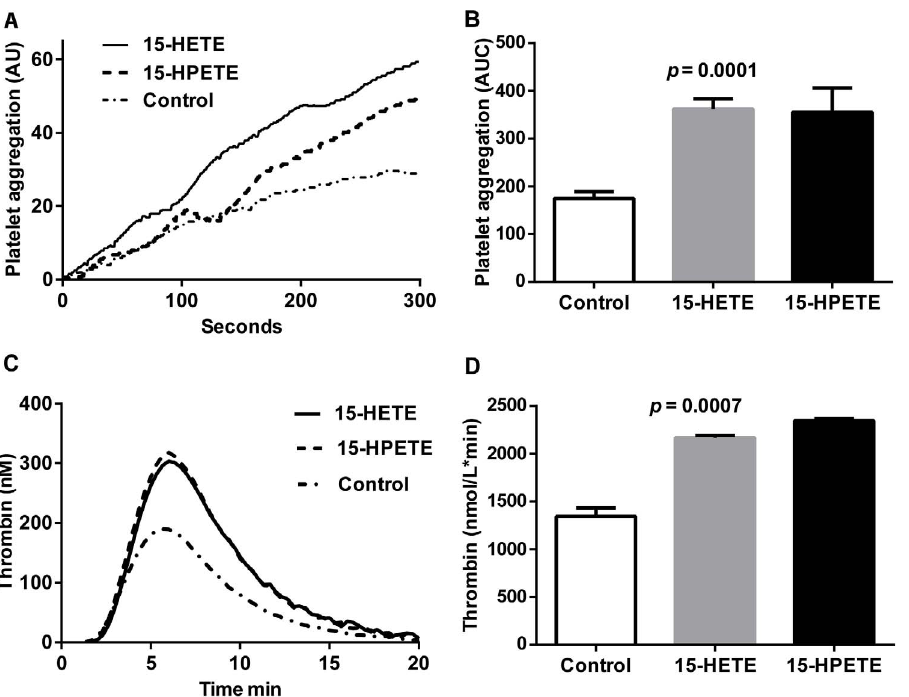
Figure 2. Platelet aggregation and thrombin formation are increased by ALOX15B enzyme products. (A, B) Platelet aggregation was measured in blood (from healthy volunteers) in the presence or absence of 10 nmol/L 15-HETE or 15-HPETE or ethanol control. ( A ) A representative experiment showing platelet aggregation over time. ( B ) Area under the curve (AUC) of platelet aggregation. Data are mean 6 SEM from 4 independent experiments (i.e. 4 blood donors) analyzed in duplicate. ( C, D ) Thrombin generation was measured in pooled normal plasma in the presence or absence of 10 nmol/L 15-HETE or 15-HPETE or 2% DMSO control. ( C ) A representative experiment showing thrombin generation curves. ( D ) The total amount of thrombin activity assessed as the area under curve (i.e. the endogenous thrombin potential). Data are mean 6 SEM from 4 independent experiments analyzed in duplicate.